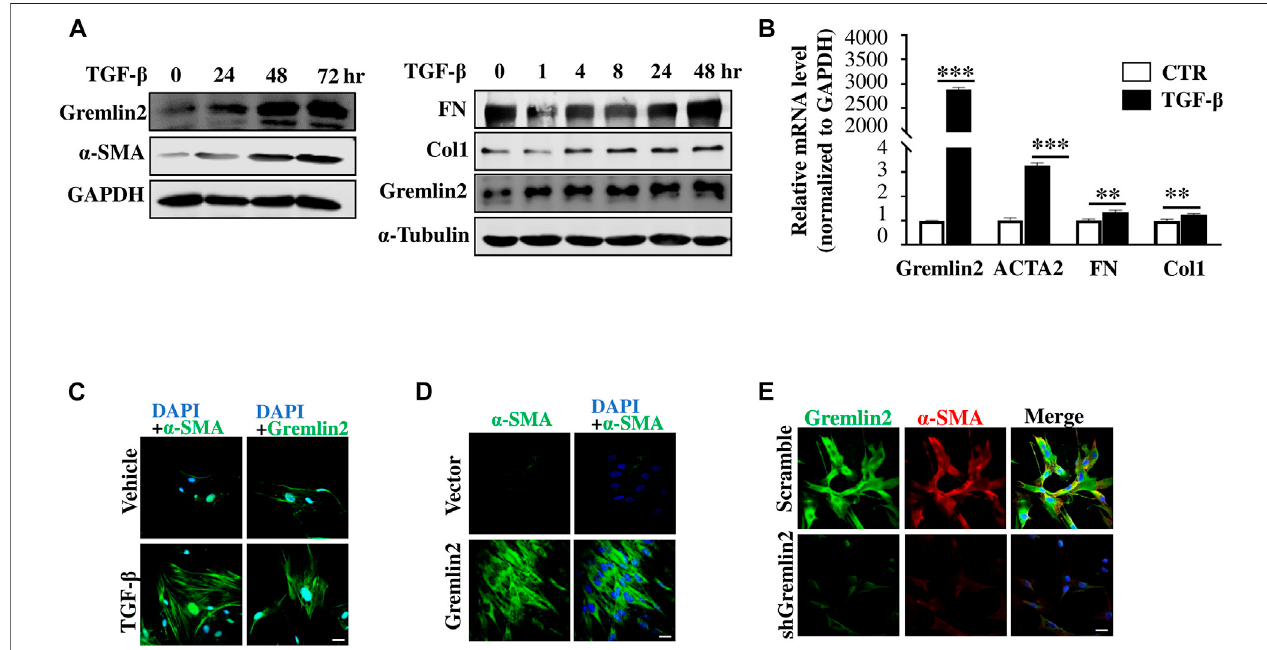
FIGURE 5 | Gremlin2 is an activated regulator to fi broblast (A) HFL-1 were collected after treatment with TGF- β 1 at 5 ng/mL for 0, 24, 48, and 72 h. Protein expression was detected using western blotting, with GAPDH as aquantitative indicator protein, α -SMAas an indicator of fi broblastactivation, and Gremlin2 as atarget protein (this experiment wasrepeatedthree times). Thesametreatment applied to HFL-1 cellswithTGF- β 1at 5 ng/mL for 0,1, 4, 8,24, and 48 h. Western blottingwas usedtodetect fi bronectinandcollagen1expression. α -Tubulinwasusedasthequantitativeindicatorprotein. (B)